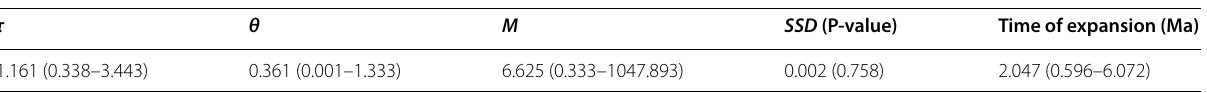
Table 5 Estimated spatial expansion parameters of τ , θ and M for Begonia luzhaiensis based on trnC - ycf6 spacer sequence